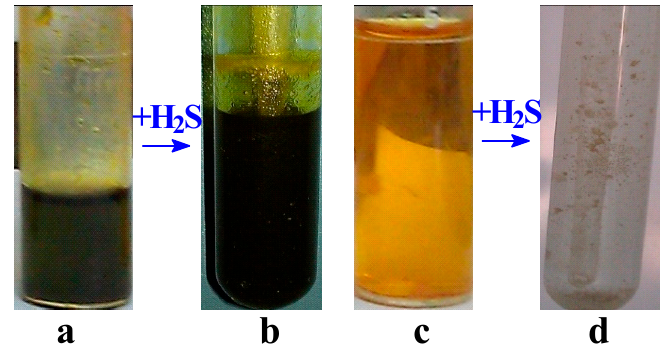
Figure 5. Photo of homogeneous [bmim]Fe(III)Cl 4 –H 2 O mixtures at different x (H 2 O) values: ( a ) x (H 2 O) = 30%, ( b ) x (H 2 O) = 30% after bubbling H 2 S, ( c ) x (H 2 O) = 90%, and ( d ) x (H 2 O) = 90% after bubbling H 2 S. However, it is difficult to prevent the suspended S 8 from the formation of sulfur